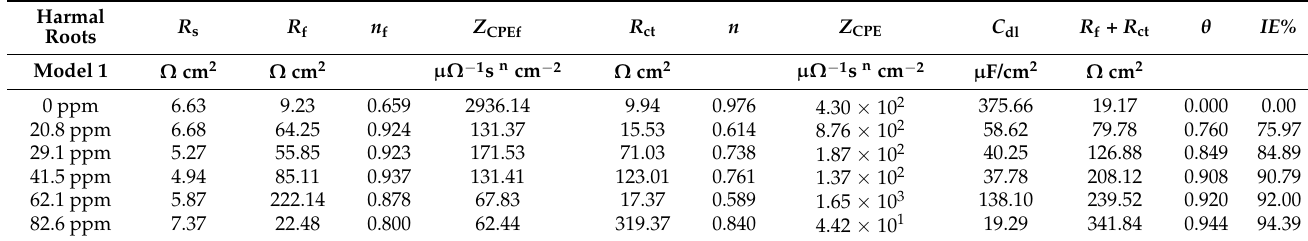
Table 1. Impedance parameters for the Harmal roots extract on the C-steel in 0.25 M H 2 SO 4 medium by fitting the equivalent circuit model 1.